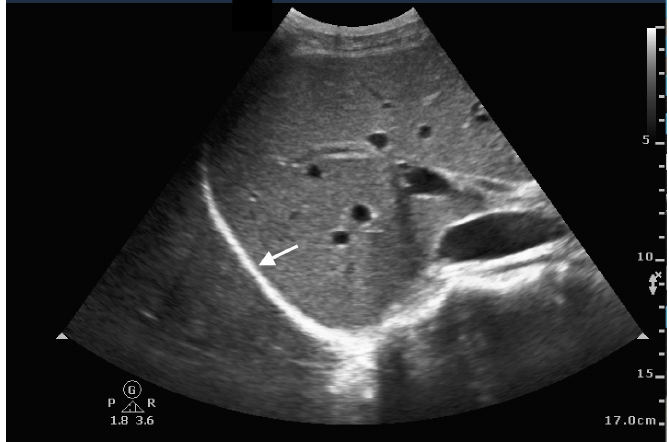
Figure 1b. Ultrasound of normal lung: note the mirror image artifact: appearance of liver above and below the diaphragm (arrow) and the absence of a spine